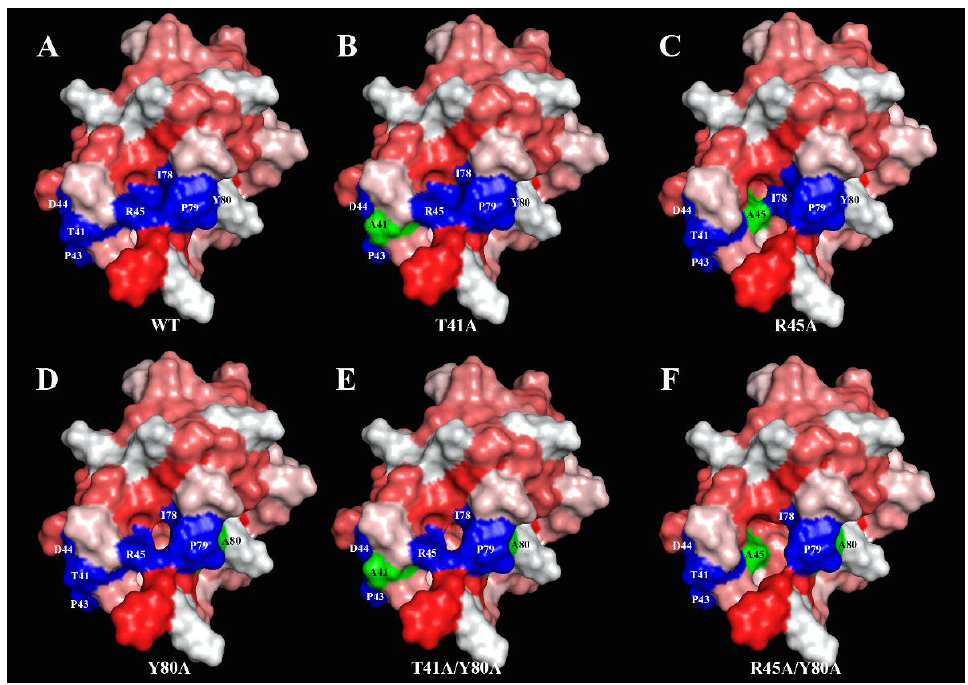
Figure 3. The NMR solution structure of the ligand-free Len c 3 (2MAL) ( A ) and structures of the mutant analogues of Len c 3 predicted by computer simulation ( B – F ). Hydrophobicity is displayed in a normalized consensus Eisenberg scale (the more positive the value, the more hydrophobic the amino acid residues). Amino acid residues crucial for IgE-binding (Thr41, Pro43, Asp44, Arg45, Ile78, Pro79, and Tyr80) [15,24] are shown in dark blue. Amino acid substitutions are displayed in green.